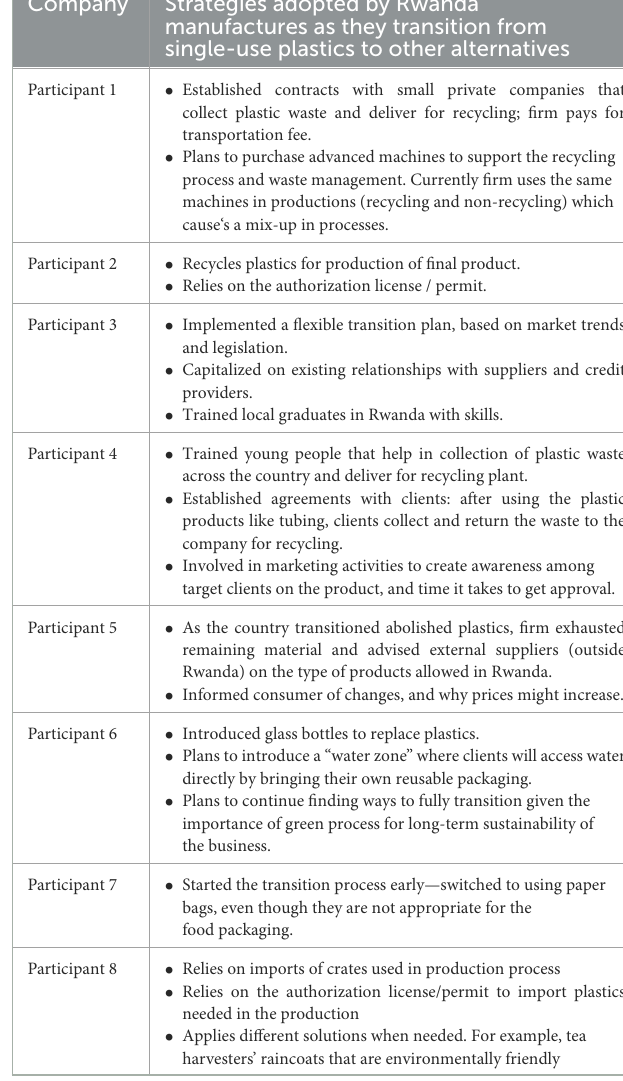
TABLE 5 Government support provided to manufacturers during the transition process. Nature of government Nature of support required support (how government and